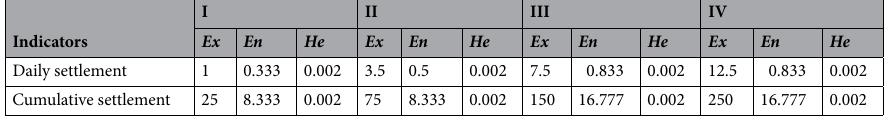
Table 6. Cloud models parameter value of the two monitoring indicators.